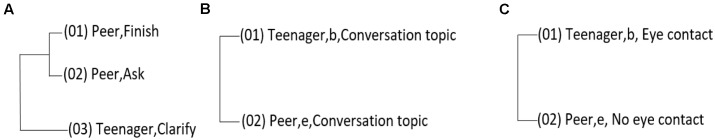
Interactional hidden patterns found between CG adolescents and their peers. The first pattern (A) shows a sequence of inquiry; the second pattern (B) shows adolescent and peer within the topic of conversation, where the teenager talks and the other opts to keep silence; and the third pattern (C) reflex the difficul to mantence mutual eyes contact.